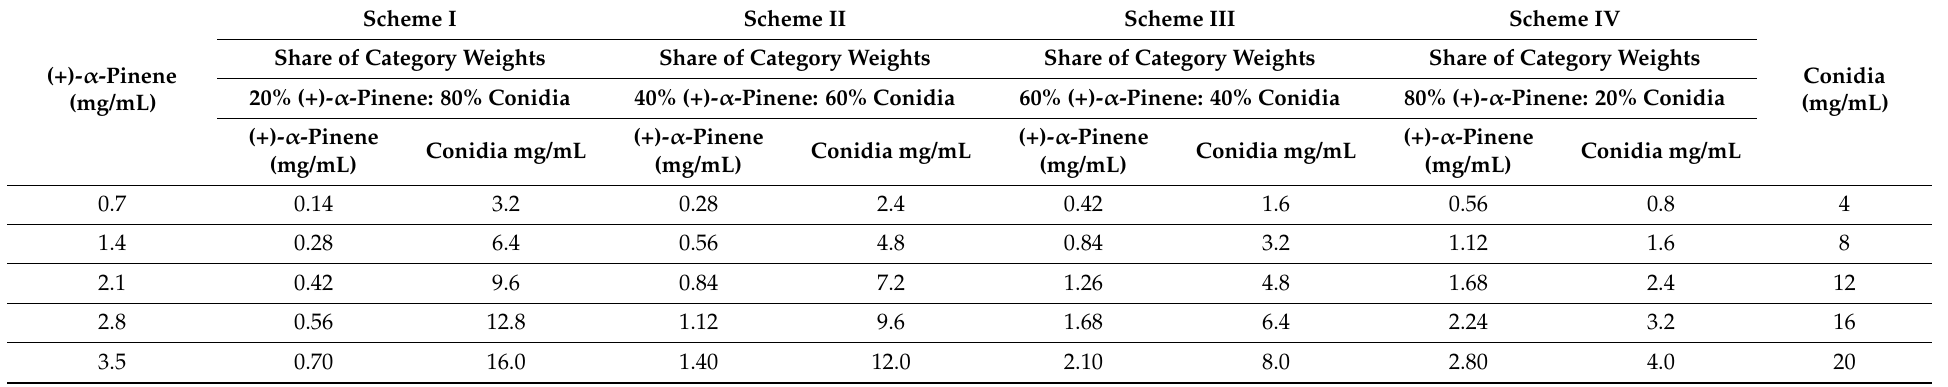
Table 2. Overview of the (+)- α -Pinene and B. bassiana ARSEF 8465 combination bioassays to record the nature of their